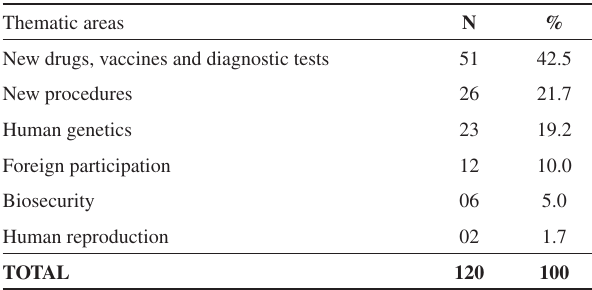
Table 2 - Research in special thematic areas Thematic